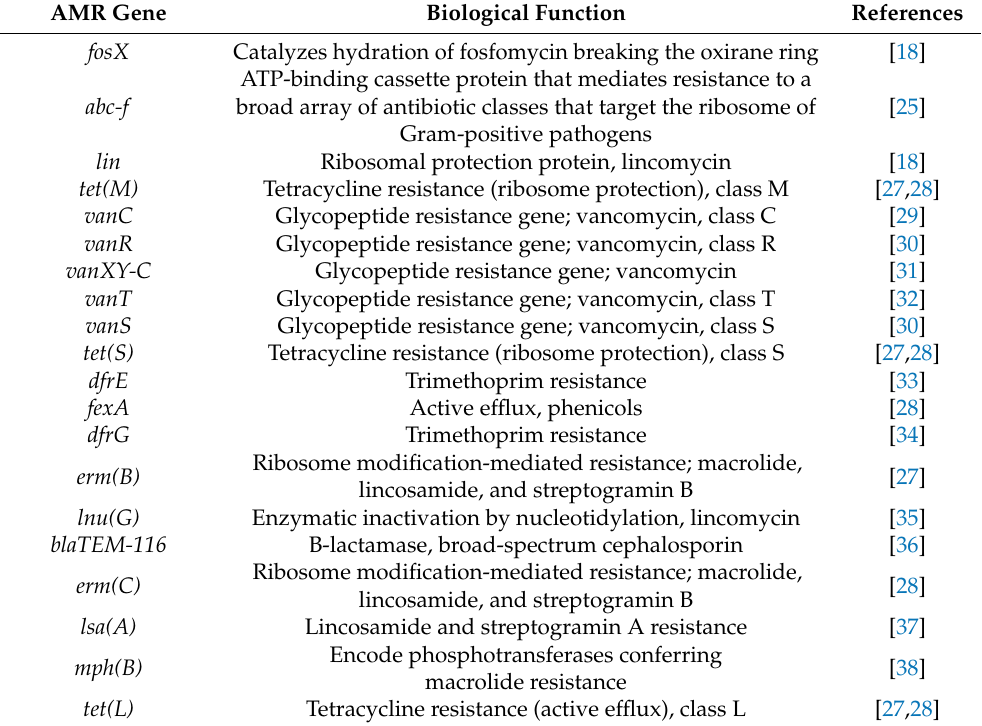
Table 5. Biological functions of highly occurring AMR genes.